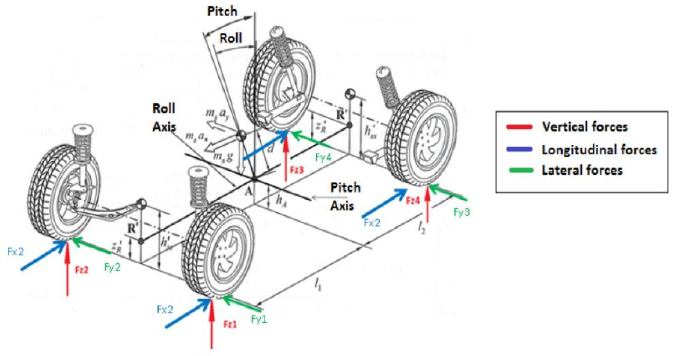
Figure 4. Detail of forces and moments applied to the vehicle. The distance d represented is broken down into d picth and d roll , concerning the pitch and roll axes of rotation, respectively. The figure references